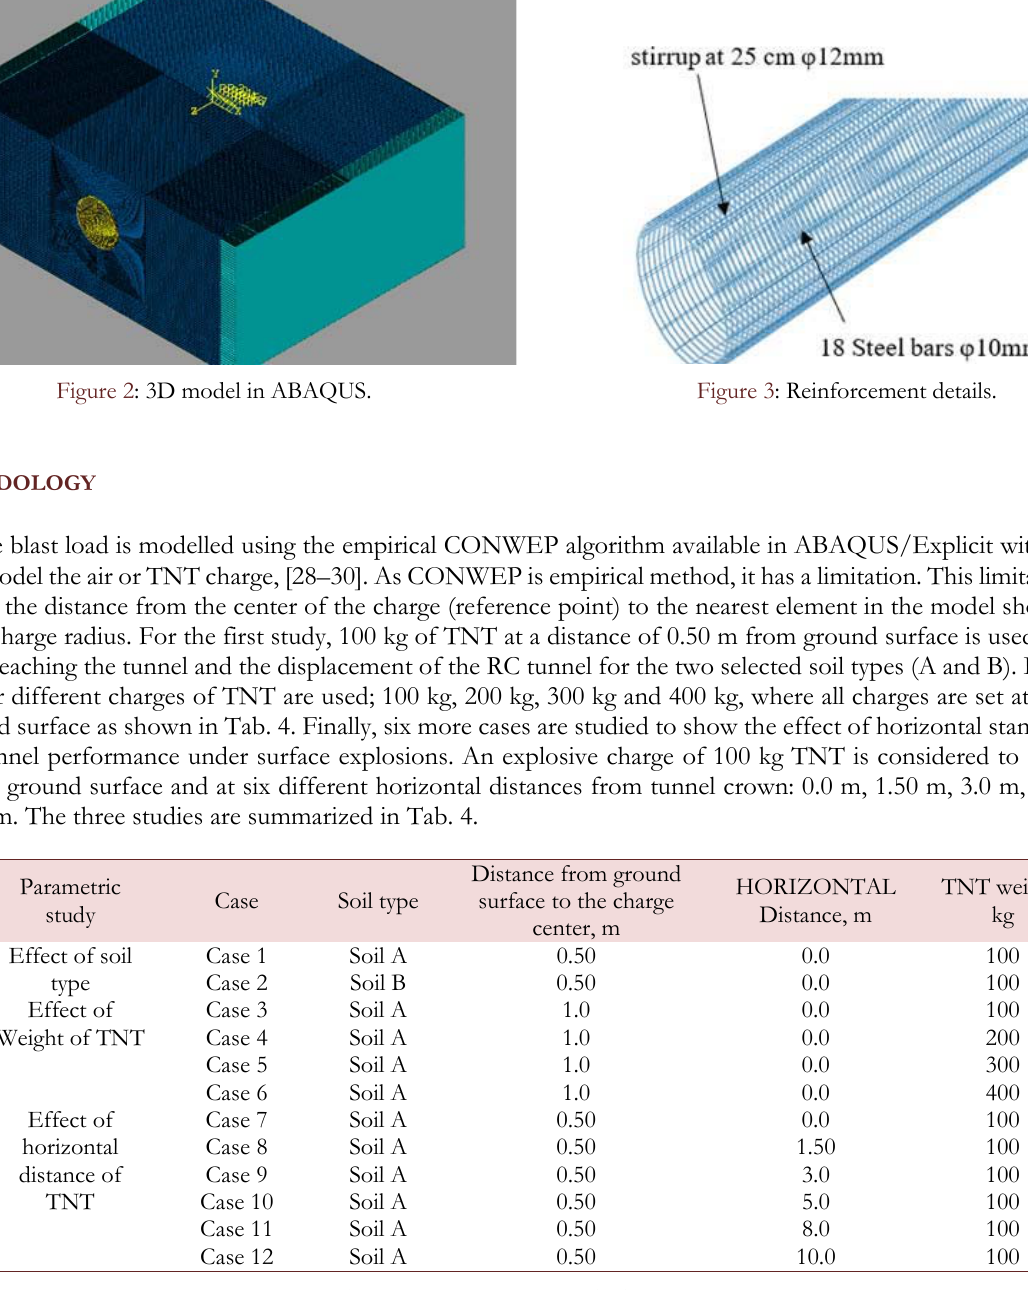
Table 4: Summary of the studied three